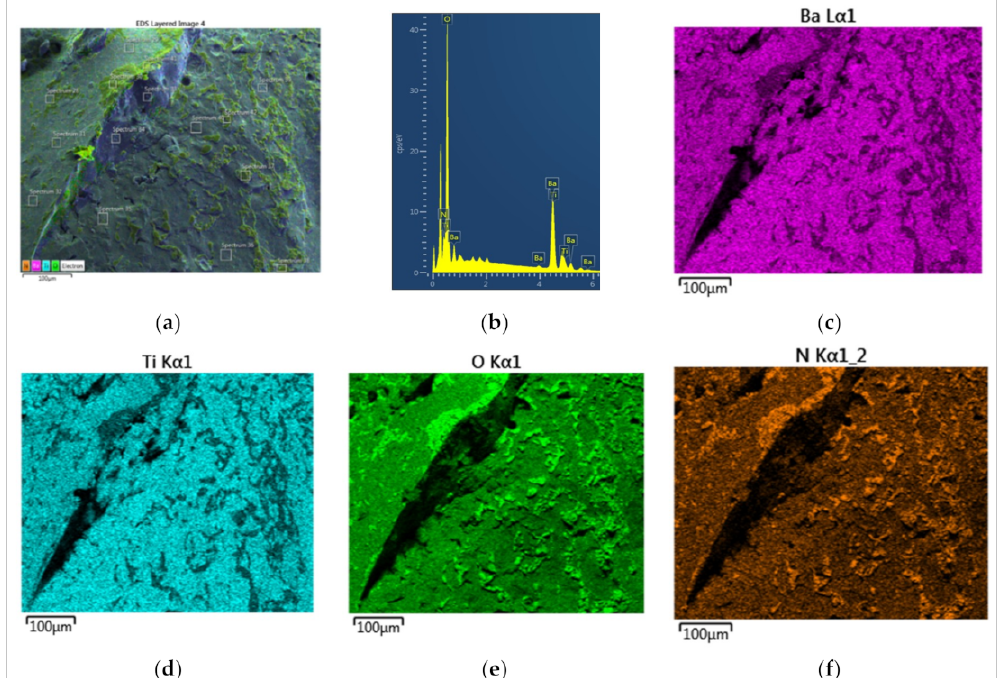
Figure 12. The e ff ect of 10 min microwave irradiation at 1800 W in air with plasma generation inside the BaTiO 3 particle (Interface region of Particles-3 and 4 in Figure 8). ( a ) EDS layered image showing the superimposed regions of O-rich and N-rich regions; ( b ) EDX-spectra of the area in ( a ) with: [O] = 0.642; [N] = 0.034; [Ba] = 0.176; [Ti] = 0.148. ( c ) Ba-mapping; ( d ) Ti-mapping; ( e ) O-mapping and ( f ) N-mapping.